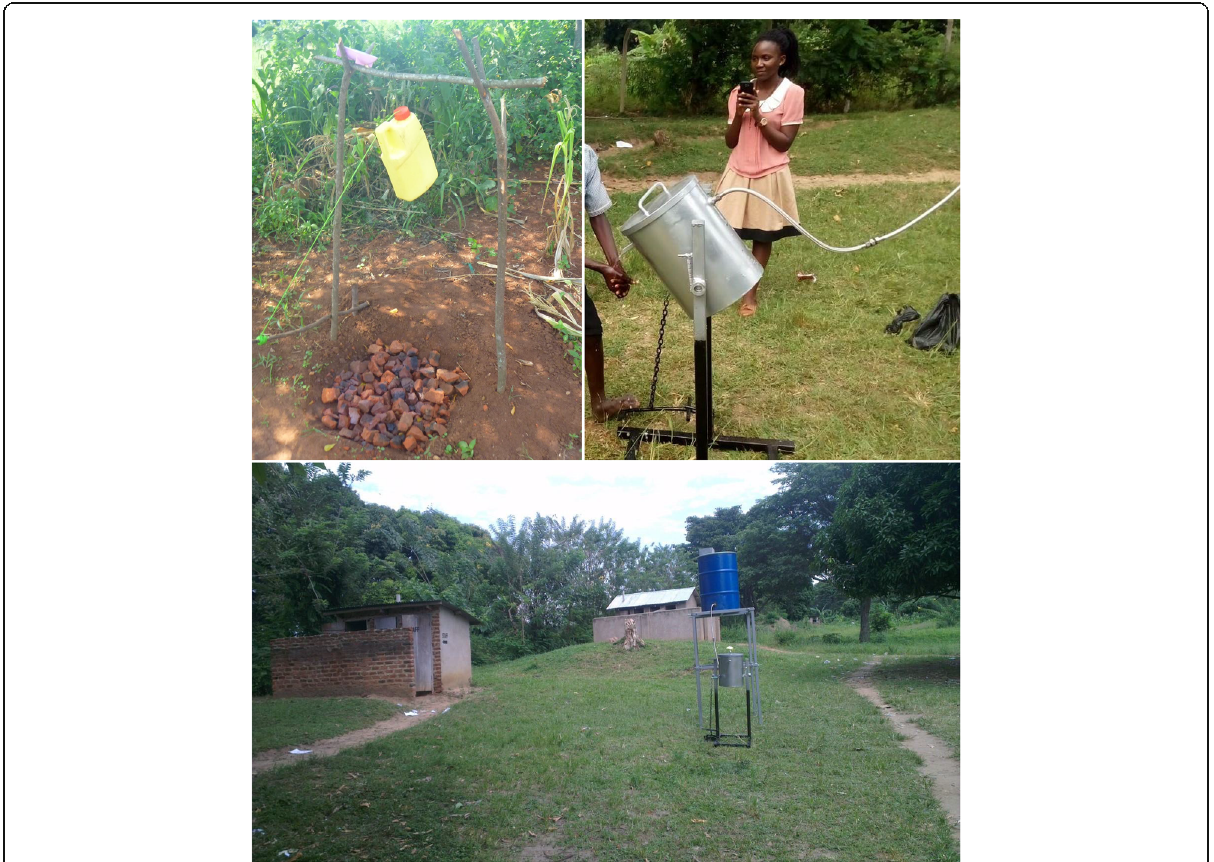
Fig. 2 Traditional tippytap (left), and an improved tippytap developed by students (right) , 2016